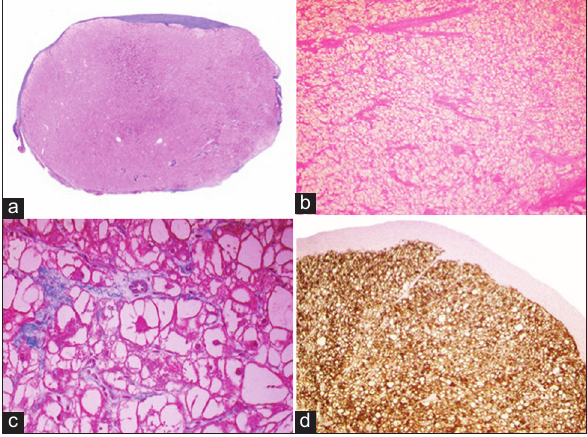
Figure 3: The nodule is almost surrounded by an incomplete fibrous capsule (a), Azan Mallory trichrome). The enlarged cleared myocytes are immersed in a slim collagen stroma (b), hematoxylin-eosin, ×100). (C), it is evident that